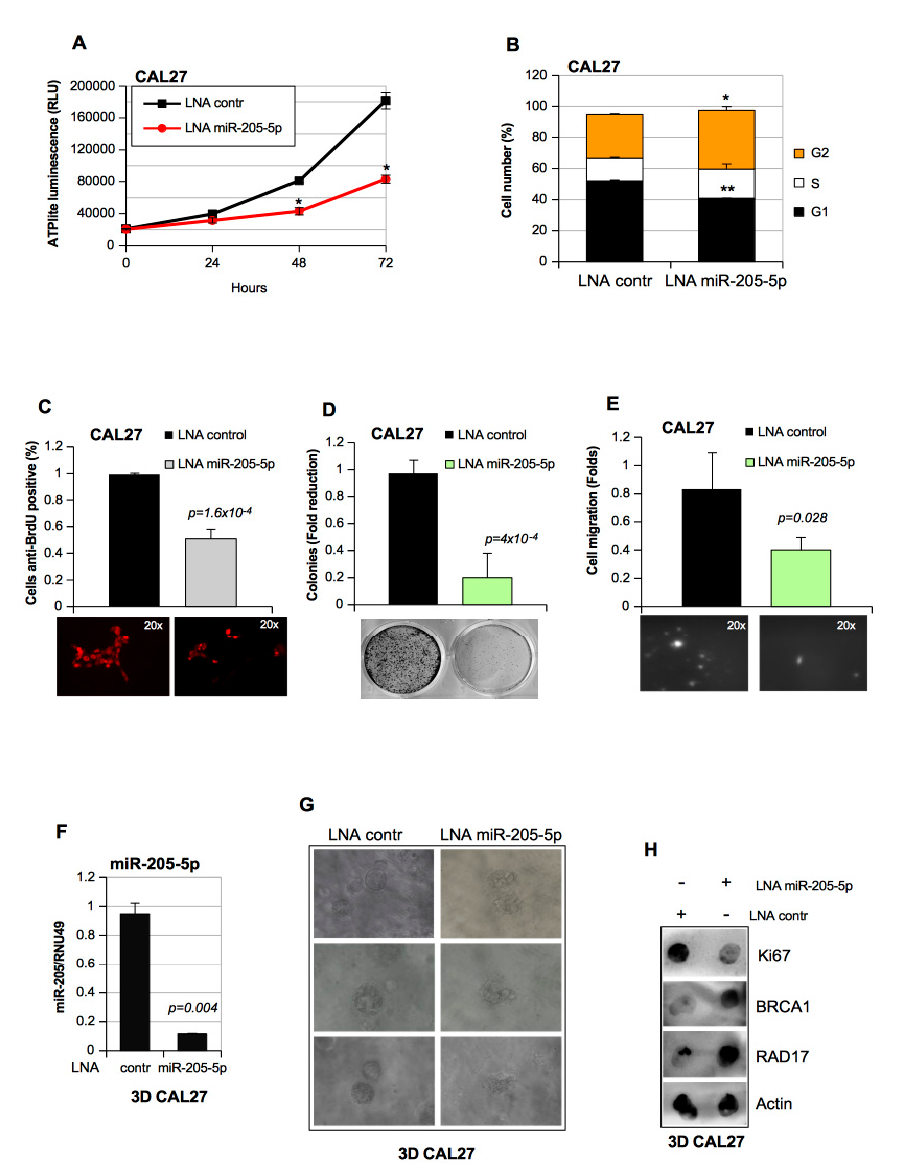
Figure 2. Inhibition of miR-205-5p impairs the tumoral features of head and neck squamous cell carcinoma (HNSCC) cell lines. ( A ) CAL27 cells transiently transfected with LNA miR-205-5p or LNA control at the indicate time points were subjected to label-free assays, and the ATP levels are expressed as relative light units (RLUs). Values are the mean ± SD obtained from two separate experiments, each plated in quintuplicate. A two-tailed t -test was used to calculate the p -values: * p < 0.05 versus the control sample. ( B ) CAL27 cells transfected for 48 h with LNA control and LNA miR-205-5p oligos were incubated with PI staining solution and analyzed by flow cytometry. The percentage of cells (%) in di ff erent phases are shown. Data are presented as the mean ± SD of three independent experiments; * p < 10 − 5 , ** p < 10 − 8 . ( C ) Cells treated the same as in (B) were incubated for 20 min with BrdU. The BrdU-positive cells were scored by immunofluorescence staining, and total cells were counted under transmission light. Data are expressed as the mean percentage of BrdU-positive cells ± SD. ( D ) CAL27 cells transfected with LNA control and LNA miR-205-5p were subjected to the colony formation assay. All the values are the mean ± SD of six replicates from three independent experiments. Analysis of the colonies was performed using the ImageJ software. ( E ) Representative images of CAL27 cells from the transwell migration assay by the Boyden chamber. Data represent the mean ± SD from three biological replicates; each point was repeated in technical quadruplicates. The p -values were calculated with a two-tailed t -test. All p -values were calculated with a two-tailed t -test and were higher than